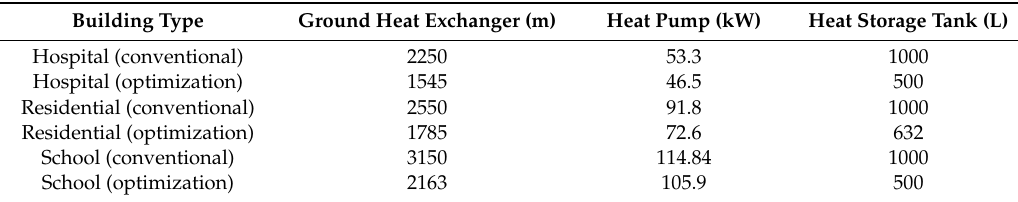
Table 6. Optimization